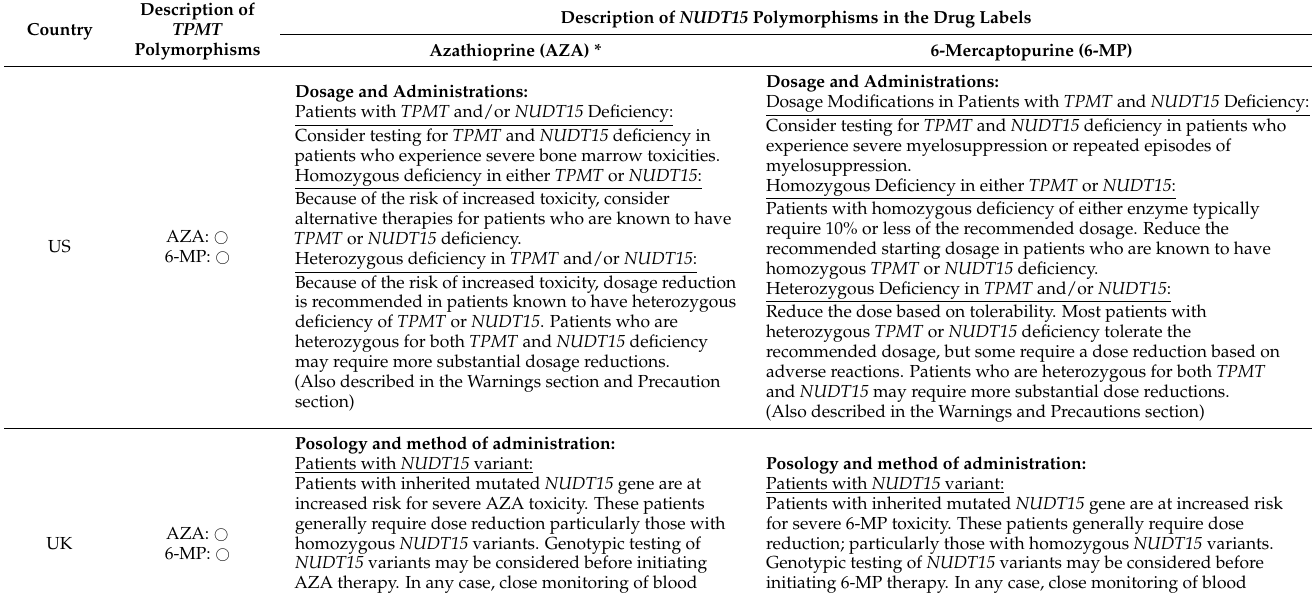
Table 3. Description of NUDT15 polymorphisms in the drug labels of